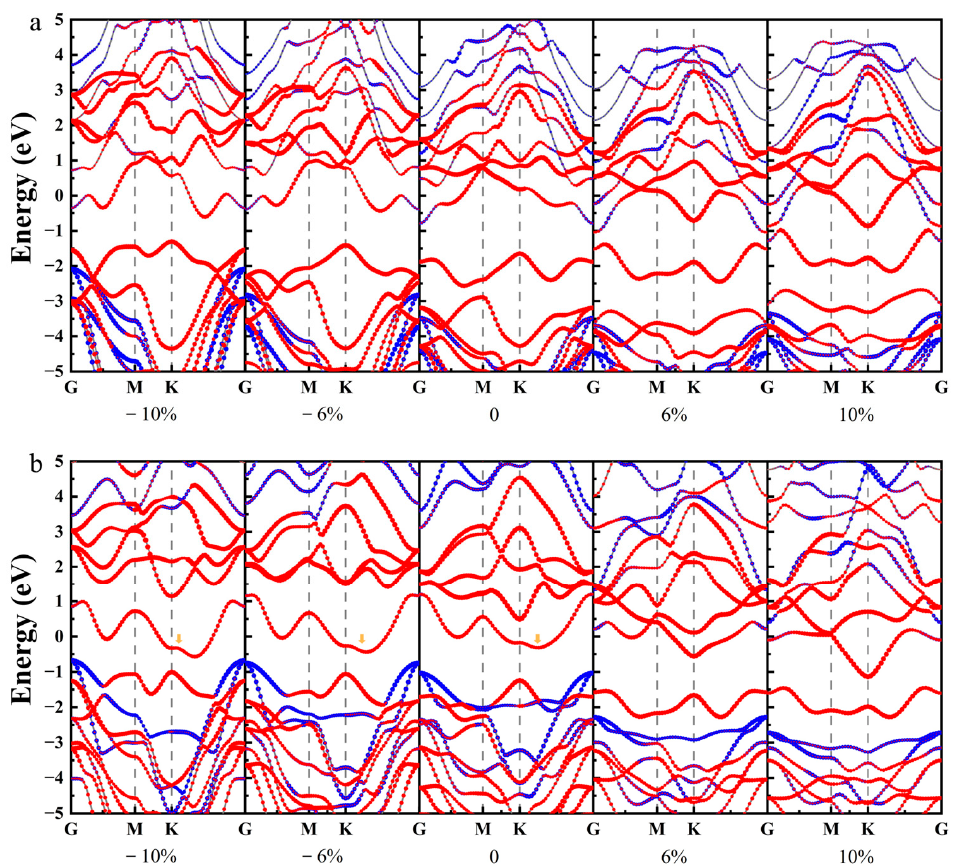
Figure 6. Projected band structures of ( a ) GaN/MoS 2 (I) and ( b ) GaN/MoS 2 (II) heterostructures under biaxial strains of − 10%, − 6%, 0%, 6%, and 10%, in which the red and blue colors indicates the contributions of MoS 2 and GaN, respectively.